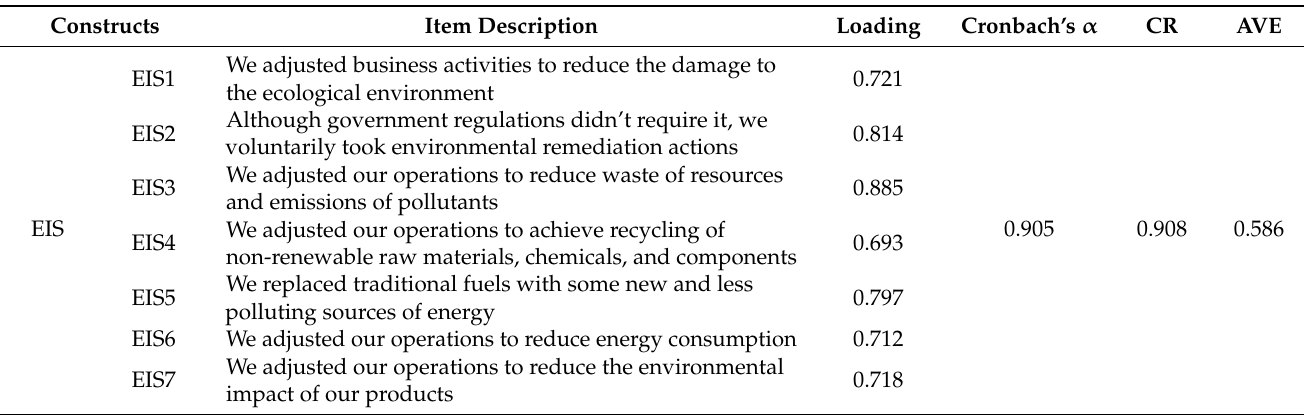
Table 2. Measurement scale items and